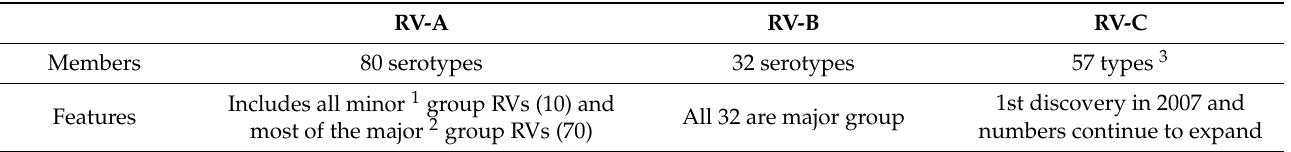
Table 1. Rhinovirus (RV) serotypes, strains and